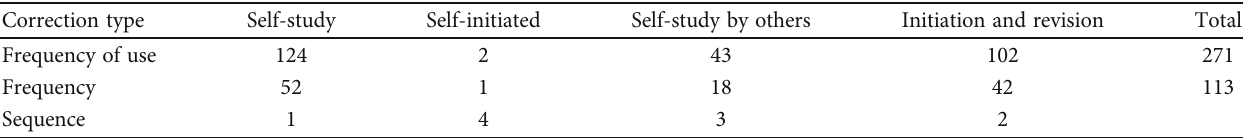
Table 3: Vocabulary emotion correction types and frequency of use by intermediate Chinese as second language learners. Correction